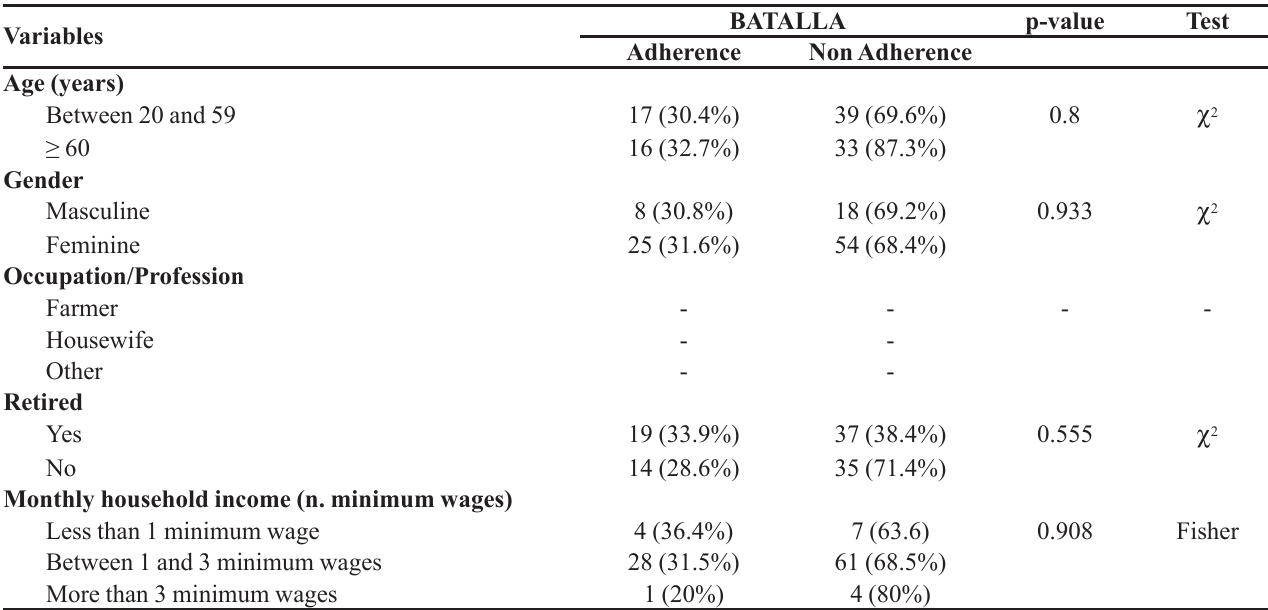
TABLE III - Distribution of sociodemographic and economic variables of Hiperdia users to analyze the association between the variables and adherence to